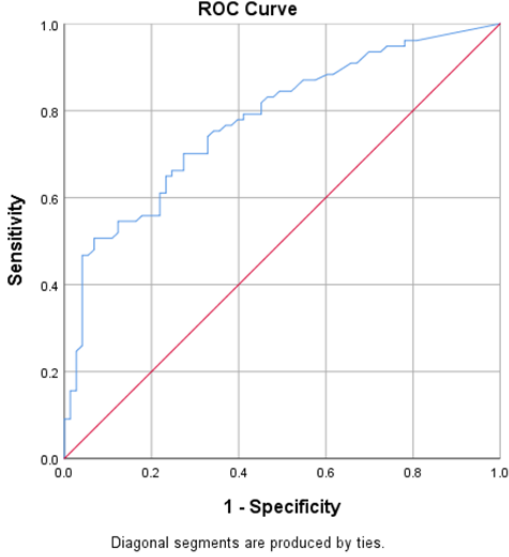
Figure 2. Predictive validity of the CRP value in predicting TB positivity.